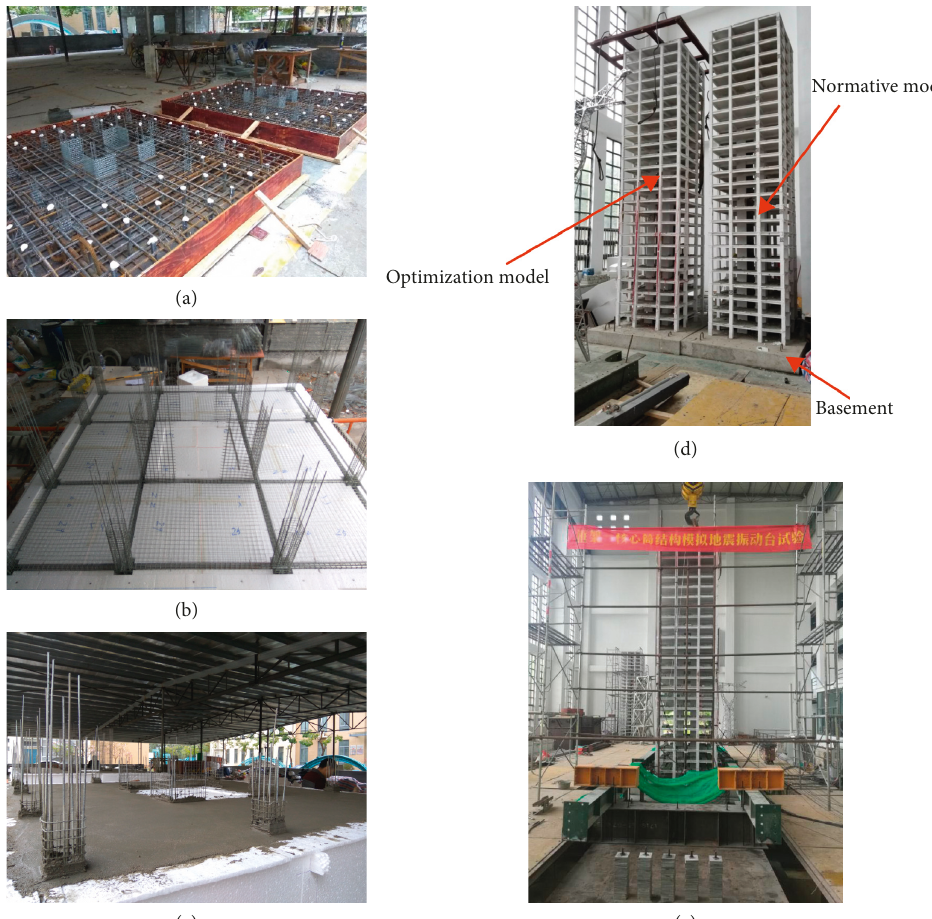
Figure 3: Model construction: (a) basement construction, (b) layout of iron wire and foam template, (c) pouring of microconcrete, (d) finish construction of models, and (e) shaking table model